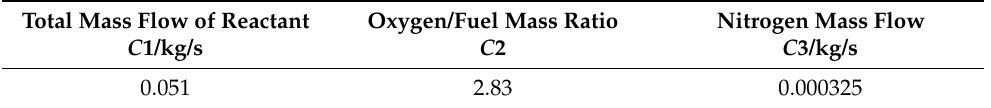
Table 5. Results of process parameter optimization.